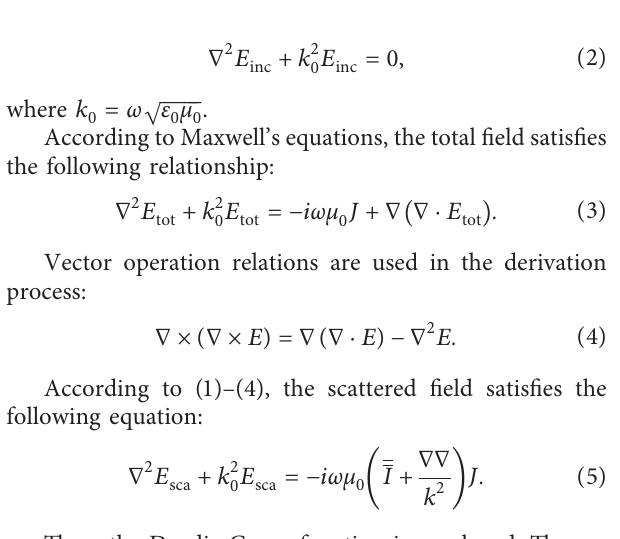
Figure 1: The basic model of microwave